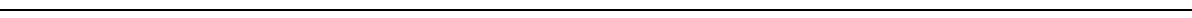
Fig. 4 Chromatin reorganization between cell types is modulated by stochastic clustering between epigenetic domains. a Two-color dSTORM image of active (H3K4me3, blue) and repressive (H3K27me3, red) chromatin marks in a representative S2 cell. Images of early and late embryos are displayed in Supplementary Fig. 4a and panel c. Scale bar = 1 µ m. b Quanti fi cation of co-occurrence (CA > 0.5) between active and repressive chromatin using aCBC 32 . Violin plots of CAs for H3K4me3 and H3K27me3 are shown in the upper panel and lower panels, respectively. The black line represents the median of the distribution. c Representative zoomed images of two-color dSTORM for the three cell types investigated. Black arrows indicate the localization of small active chromatin domains in the periphery of large repressive domains. The lower panel displays active and repressive marks of Chip-Seq enrichment pro fi les for late embryo. Scale bar = 200 nm. d , e dSTORM-rendered images of Alexa-647-labeled d H3K27me3 and e H3K4me3. Images show density maps computed from the area of the polygons obtained from the Voronoï diagram with scale de fi ned on top. Scale bar = 1 µ m. Zoomed regions display detected compartments (highlighted with different colors). Scale bar = 200 nm. Additional images for all cell types and chromatin marks are displayed in Supplementary Fig. 5a, b. f , g Population-based distribution of epigenetic domain sizes as obtained from dSTORM and predicted from ChiP-seq data for H3K27me3 f and H3K4me3 g . PDF is probability density function. Single-cell distributions of physical sizes and Chip-Seq data are shown in Supplementary Figs. 5c, d and 6b, respectively. N = 60, from two to three biological replicates in microscopy imaging. h Percentage of clustering for active and inactive chromatin marks for each cell type. Error bars = SD. One-sample t test p -values: * p < 0.01; ** p < 0.001. i Box plots of the distributions of normalized Hi-C counts between chromatin domains of H3K27me3 or H3K4me3 in embryos and S2 cells. The results were independent of matrix resolution (10, 20, and 50 kb). Boxes contain 50% of the data (0.67 σ ), and red lines mark the median values. Outliers ( > 3.3 σ away from the mean values) are shown as black dots. p -values were calculated using the Welch t